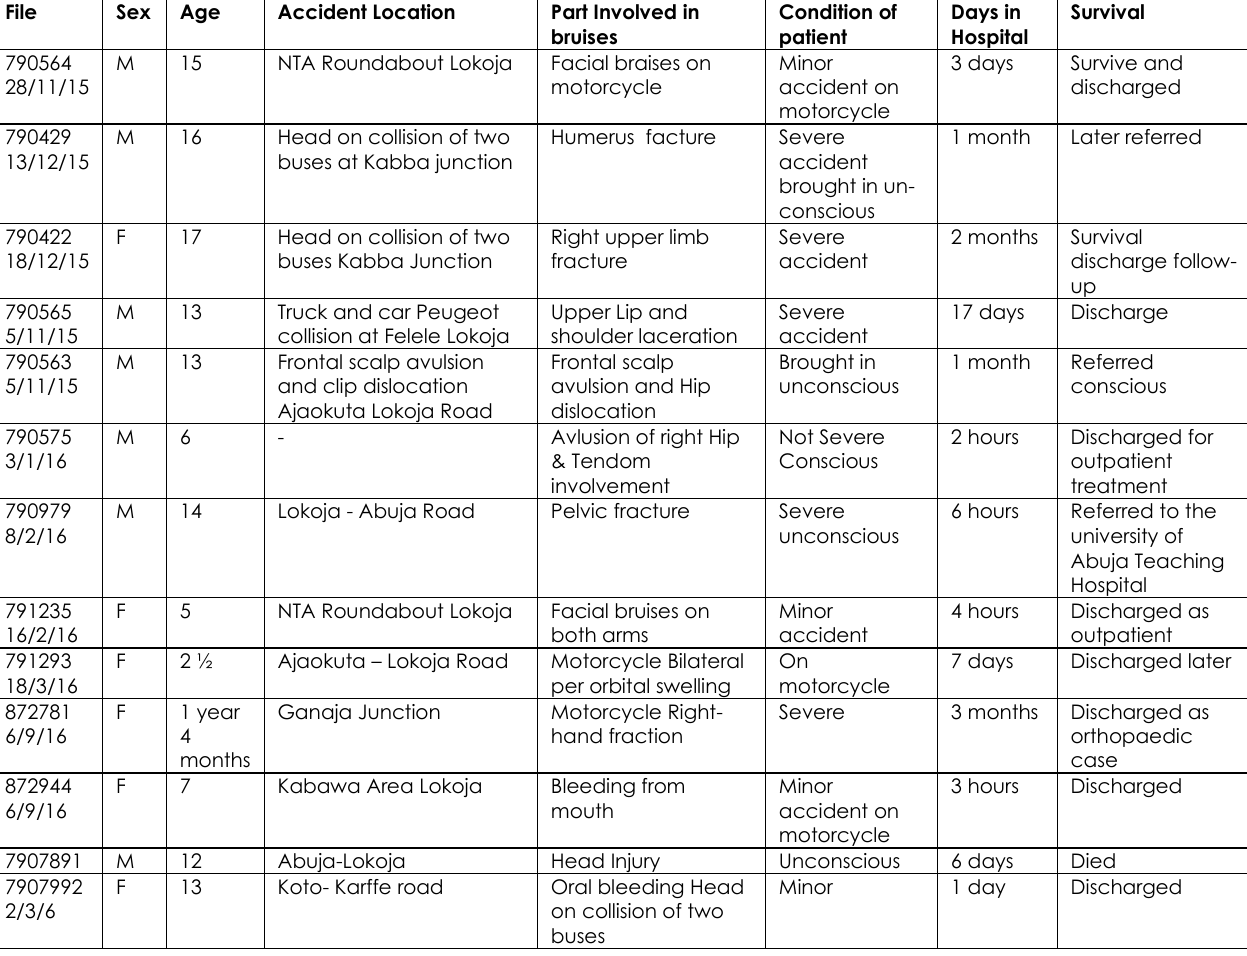
Table 8: Reported Cases of Children Involved in Road Traffic Crashes at Federal Medical Centre Lokoja, Lokoja, Kogi State